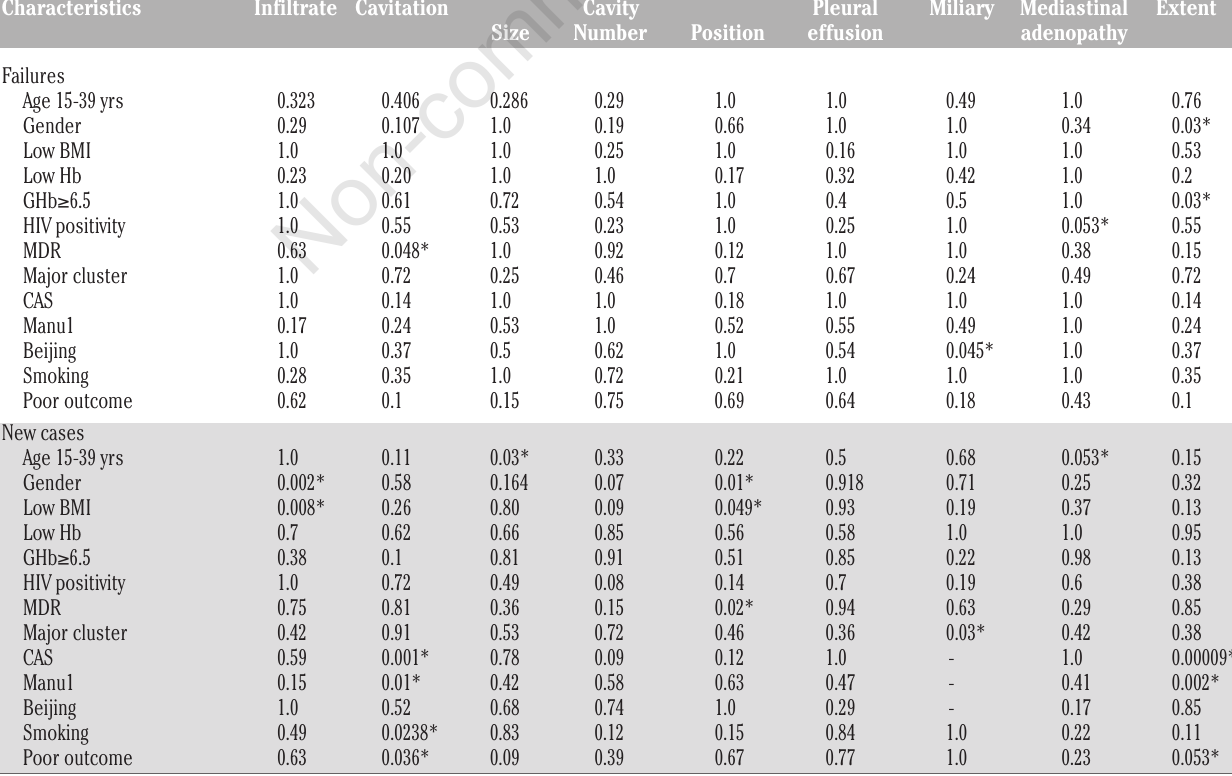
Table 2. Univariate analysis of the various X-ray features and clinical and biological parameters.